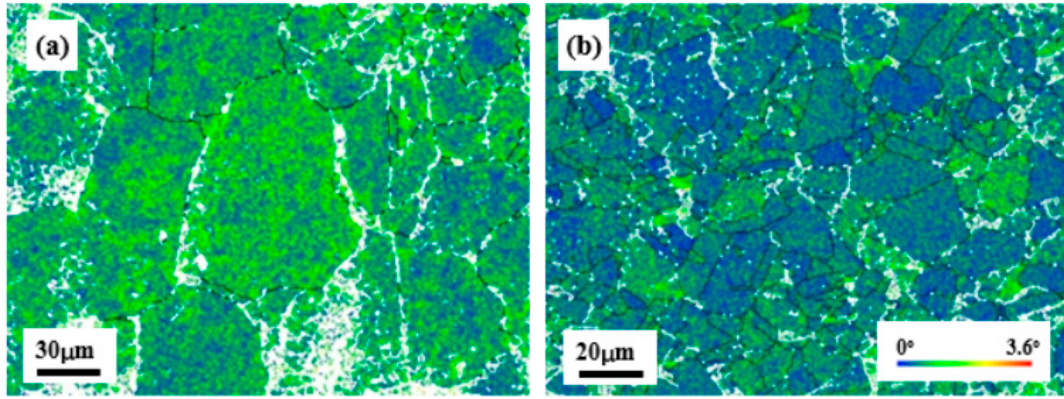
Figure 10. KAM maps, showing local orientation gradients in grain interior of ( a ) HAZ and ( b ) BM.